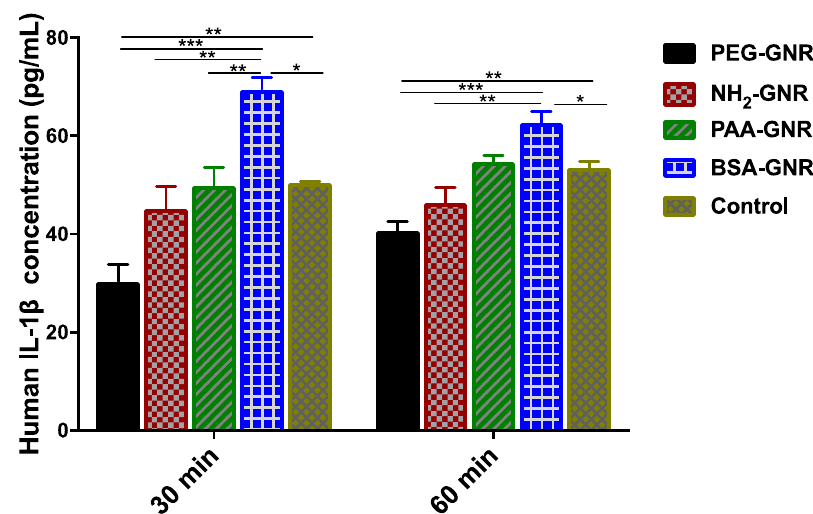
Figure 6. Concentrations of IL-1 β inflammatory cytokine released upon exposure of scratched human dermal fibroblasts to GNR of different surface modifications at different time points. PEG-GNR significantly reduced the production of IL-1 β inflammatory cytokine while BSA-GNR significantly enhanced its production upon exposure to scratched human dermal fibroblasts. Data are presented as mean ± SD. One-way ANOVA was used to estimate the statistical differences; * p < 0.05, ** p < 0.01 and *** p < 0.001.